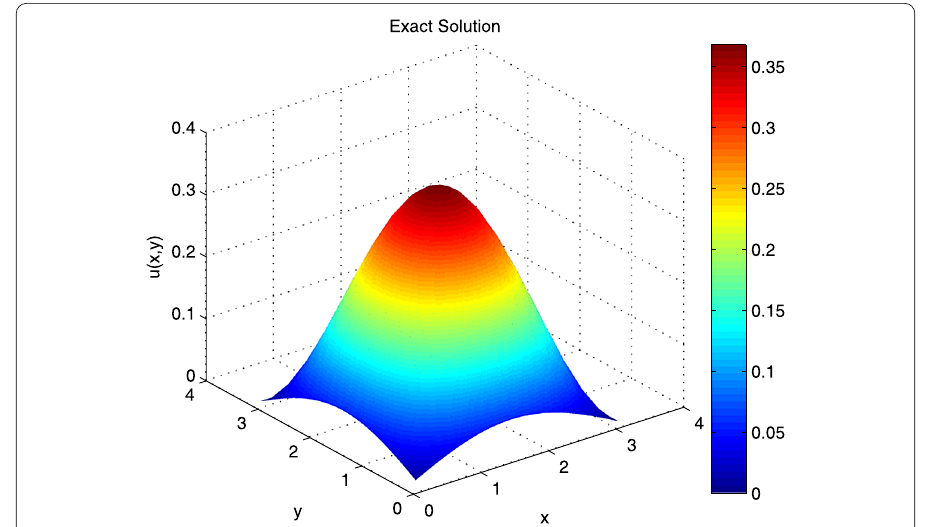
Figure 1 The profile of the exact solution for the EFK equation with γ = 0.01 at t = T =